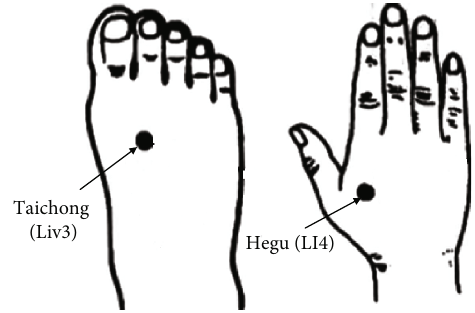
Figure 1: Location of acupoints used in the